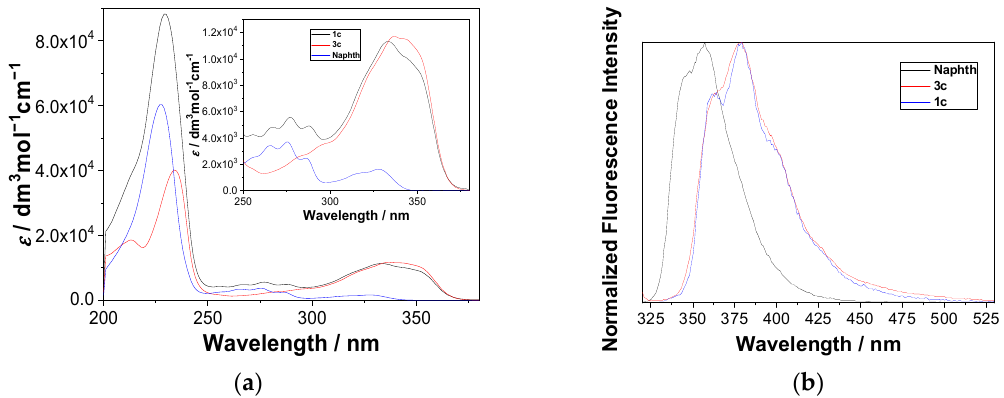
Figure 1. ( a ) Absorption spectra of Naphth, 3c and 1c in CH 3 OH-H 2 O (4:1 v / v ), ( b ) normalized fluorescence spectra ( λ ex = 310 nm) of Naphth, 3c and 1c in CH 3 CN.